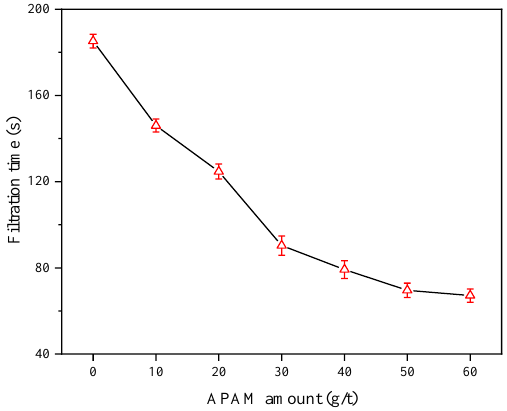
Figure 6. Filtration time with APAM dosage.